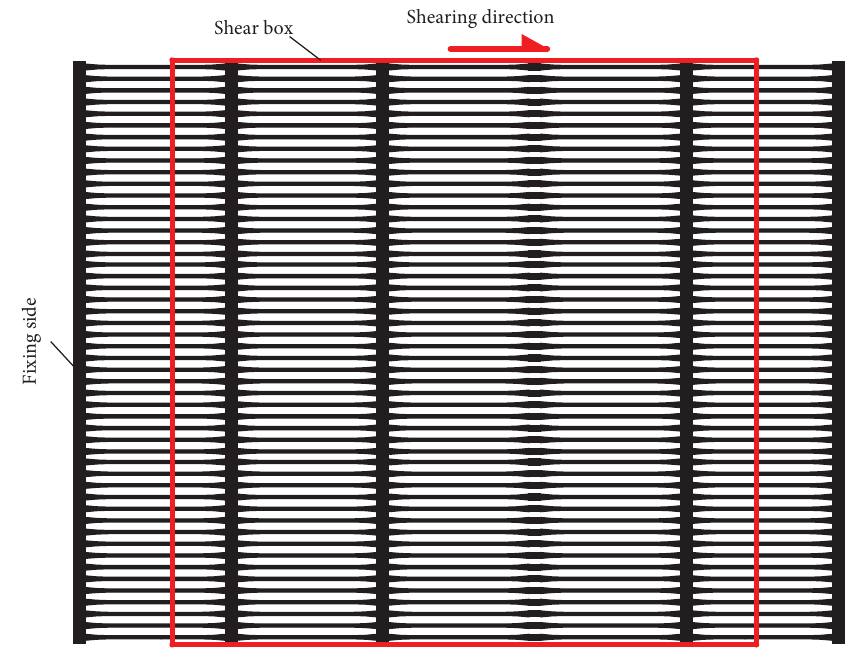
Figure 5: Geogrid with 75% cross ribs.